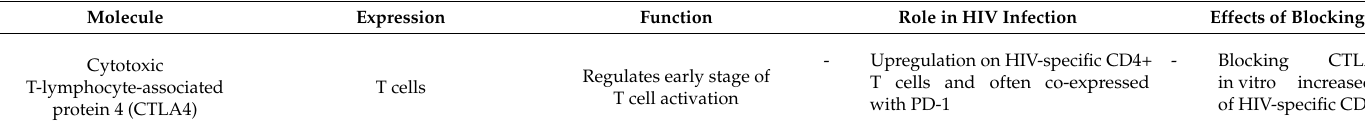
Table 1. Information about the four major inhibitory immune checkpoint molecules in HIV